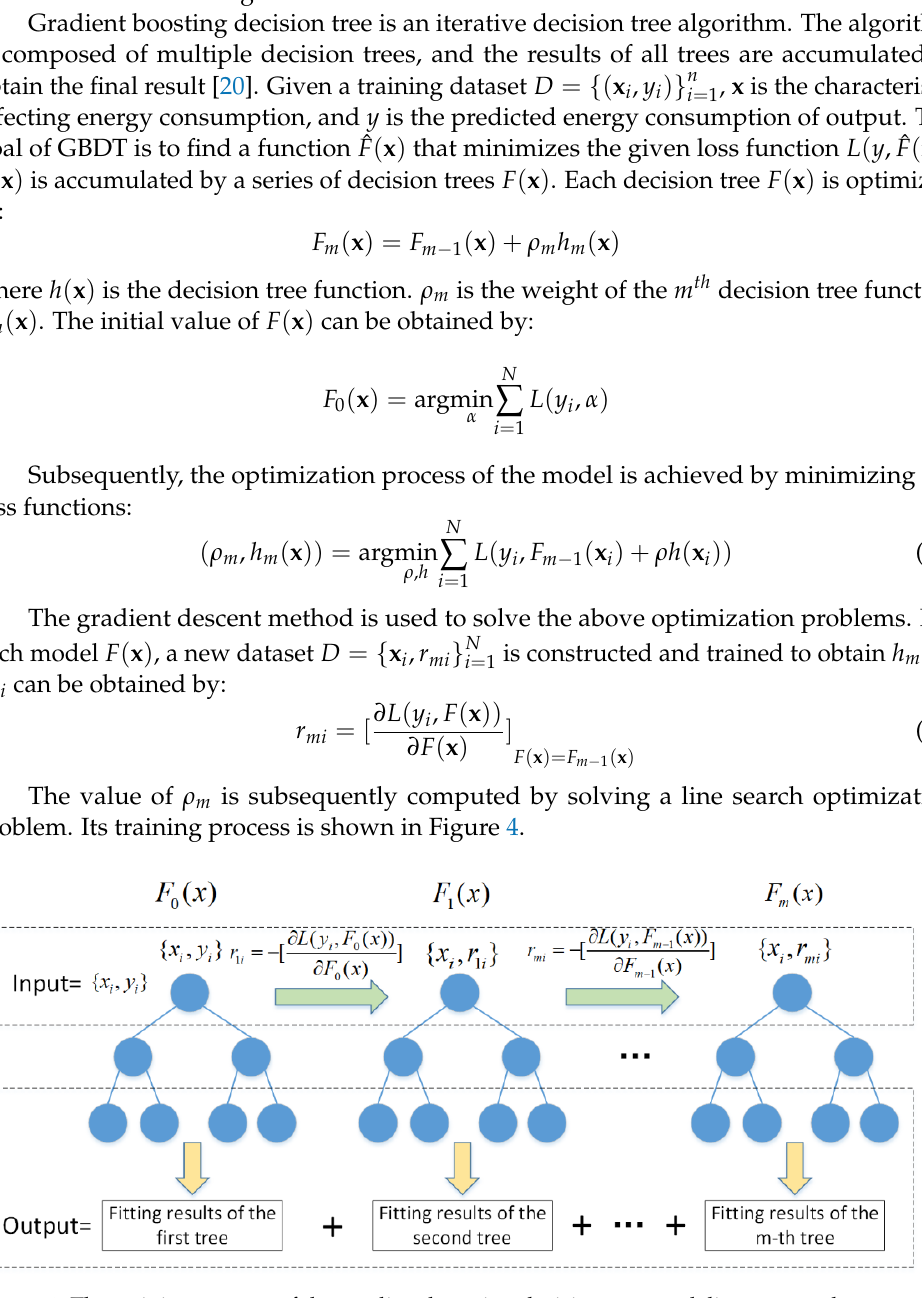
Figure 4. The training process of the gradient boosting decision tree modeling approach.